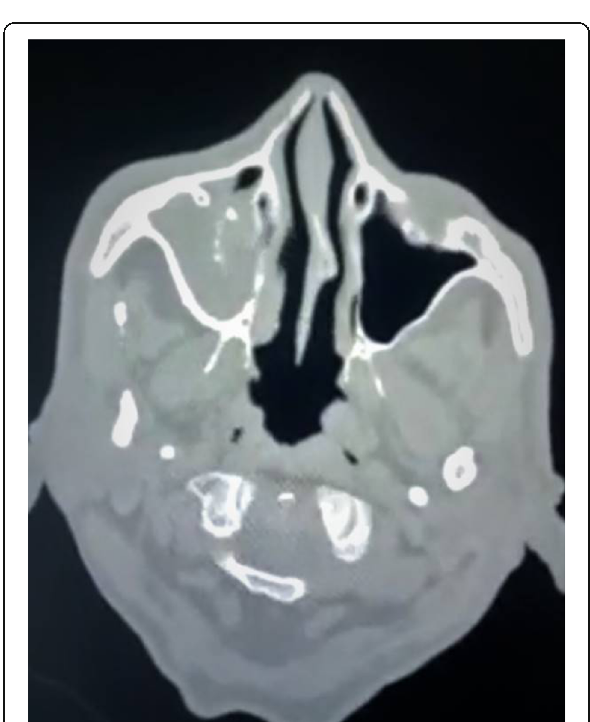
Fig. 2 (abstract P0424). See text for